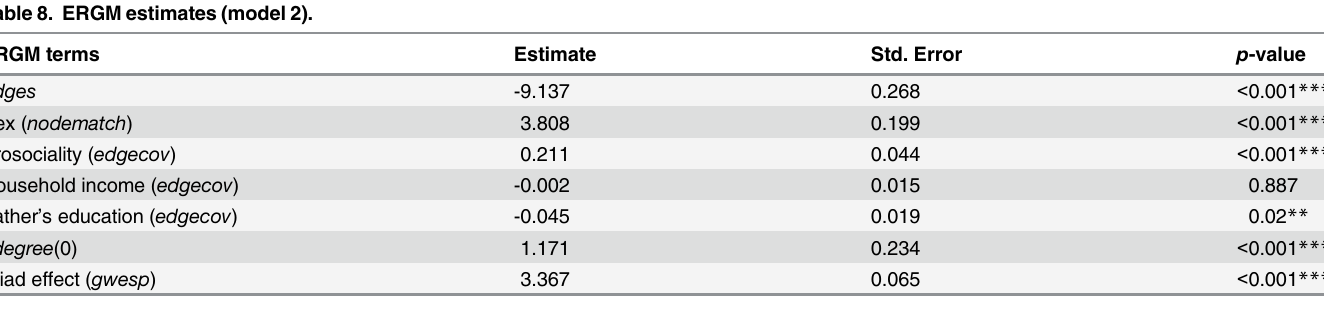
Table 8. ERGM estimates (model